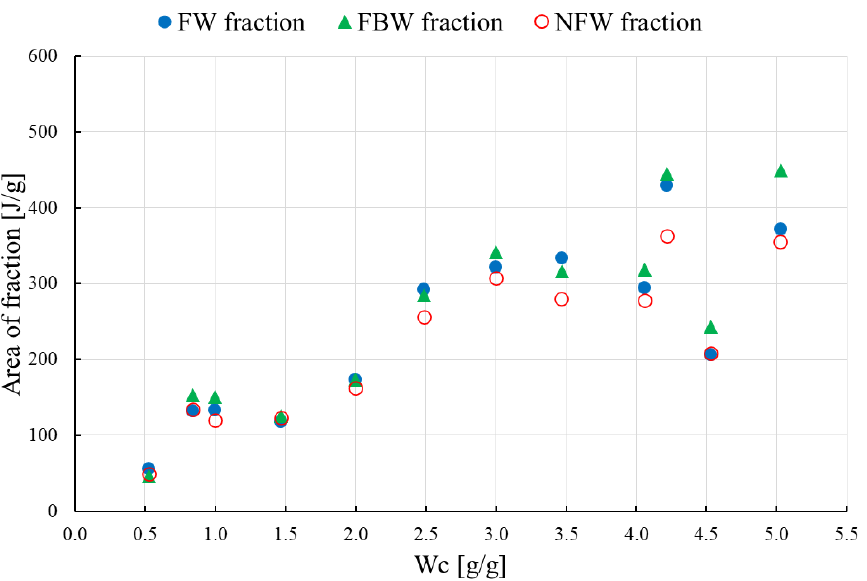
Figure 7. The area of different fractions of water, obtained after deconvolution of HPC/NaSA mixtures vs. W c . The blue circles indicate the FW fraction, the green triangles the FBW fraction, the red empty circles the NFW fraction.